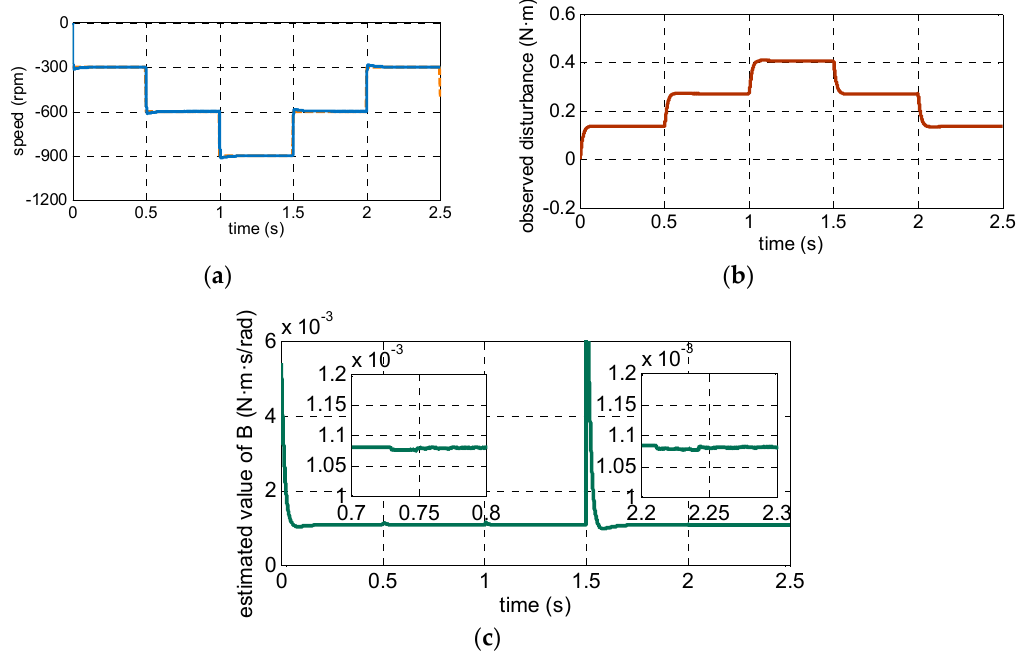
Figure 7. Simulation results under a speed step of ±300 rpm for B 0 = 5 B : ( a ) Measured speed; ( b ) observed disturbance value for parameter mismatch error Δ B ; ( c ) estimated value of parameter B .